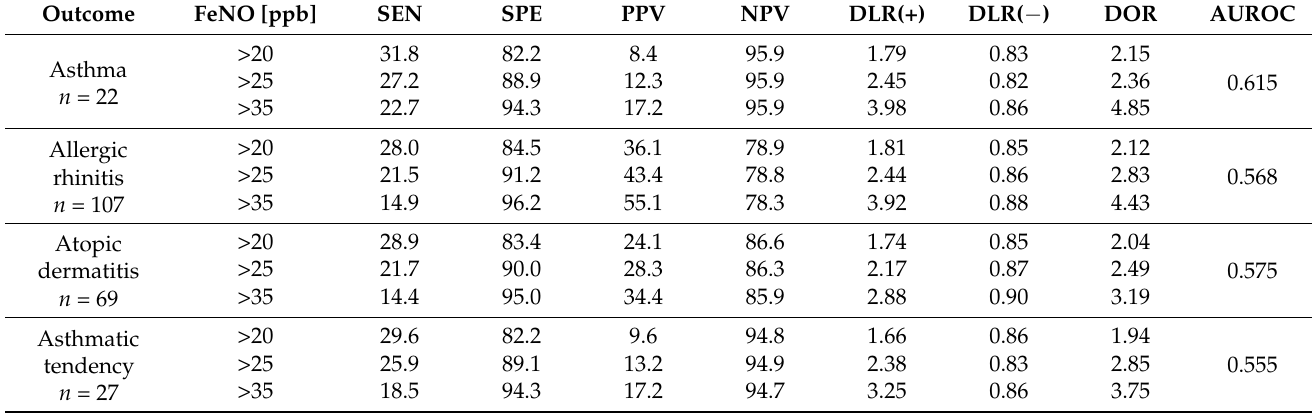
Table 3. Diagnostic accuracy (sensitivity, specificity, positive and negative predictive value, positive and negative diagnostic likelihood ratio, diagnostic odds ratio, and area under curve) of FeNO in detecting treated asthma, allergic rhinitis, atopic dermatitis, and asthmatic tendency in all